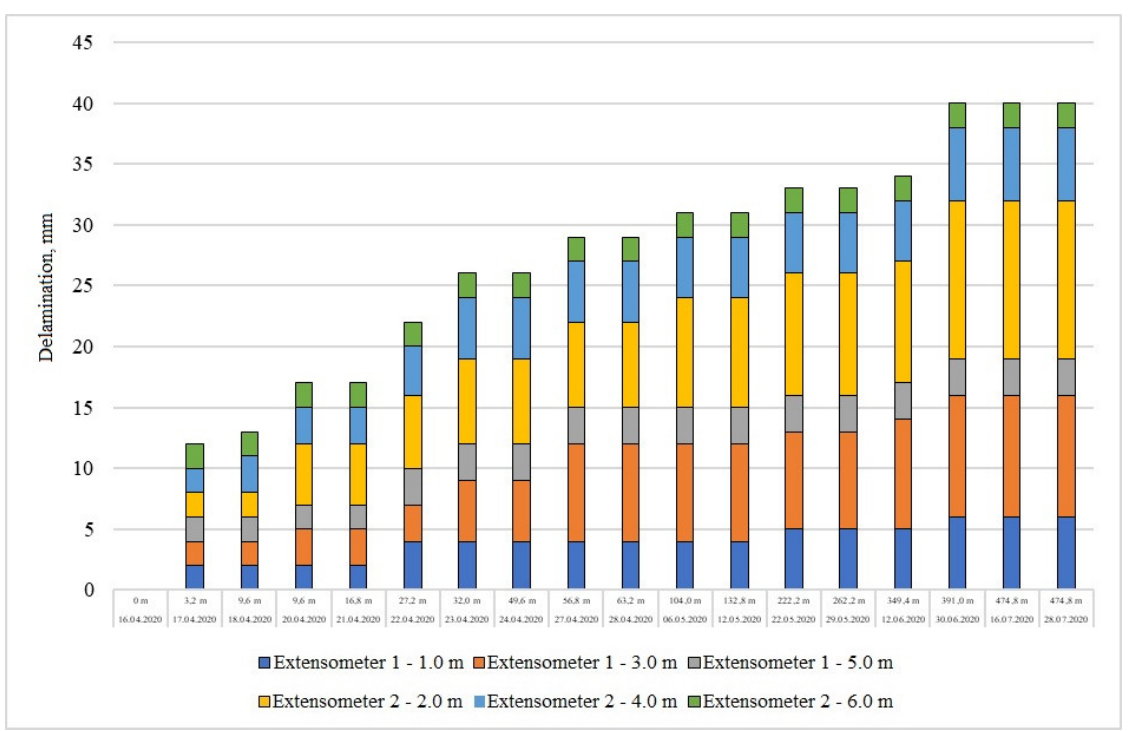
Figure A3. Roof delaminations measured using multilevel mechanical extensometer—periodic control station no. 4.